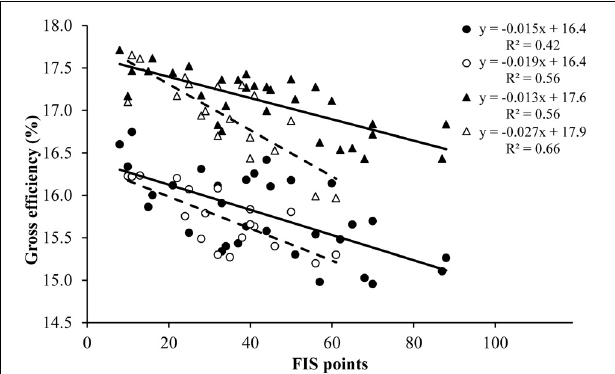
FIGURE 2 | Gross efficiency plotted against FIS points for 31 males and 19 females elite cross-country skiers while roller ski skating on a 5 and 12% inclined treadmill in the G3 and G2 skating technique respectively. Individual values and trend lines (based on linear regression) are shown for men (filled symbols, solid line) and women (open symbols, dashed line) and for the 5% (circular symbols) and 12% incline (triangular symbols).